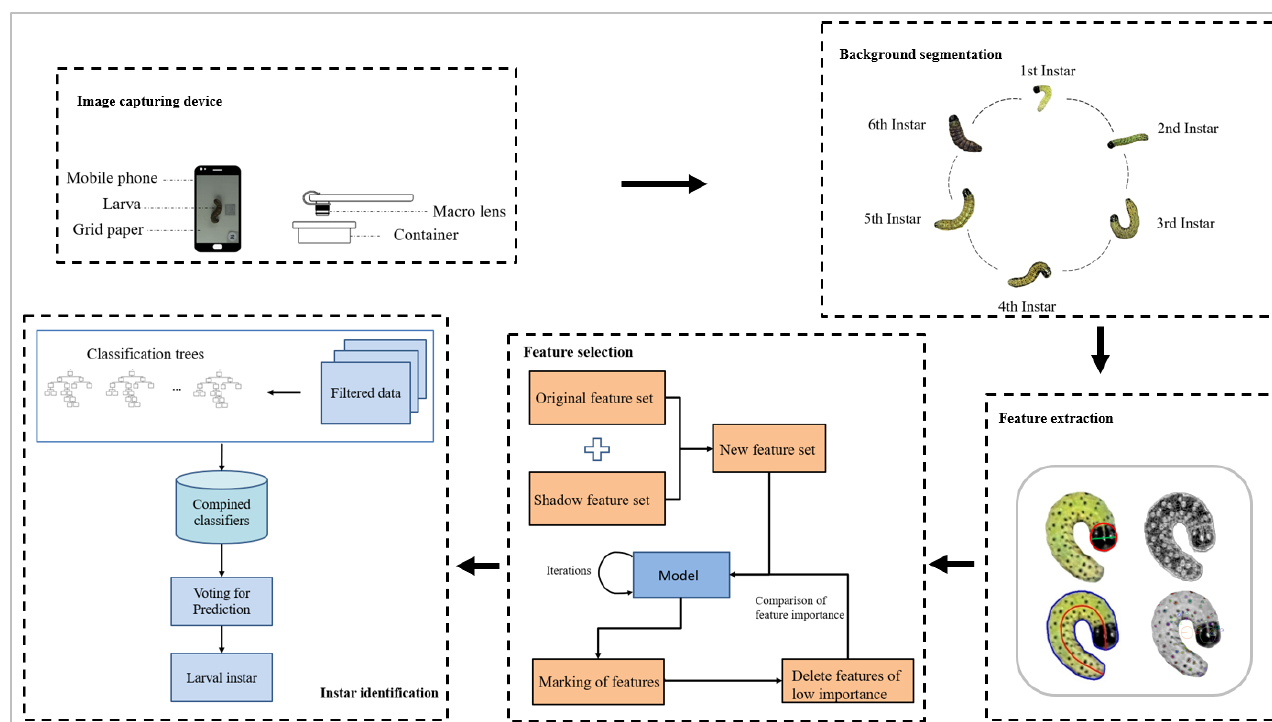
Figure 1. The identification pipeline of FAW larval instars.